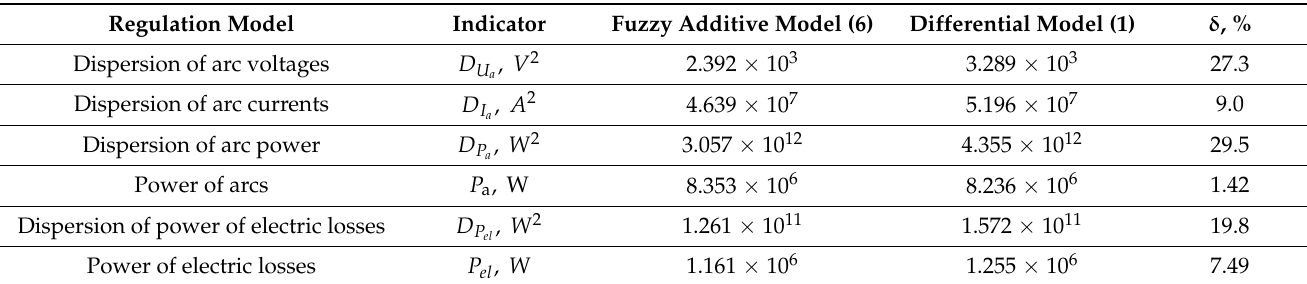
Table 1. Indicators of dynamics quality and energy efficiency during random perturbations control at the stage of penetration of wells in solid charge.